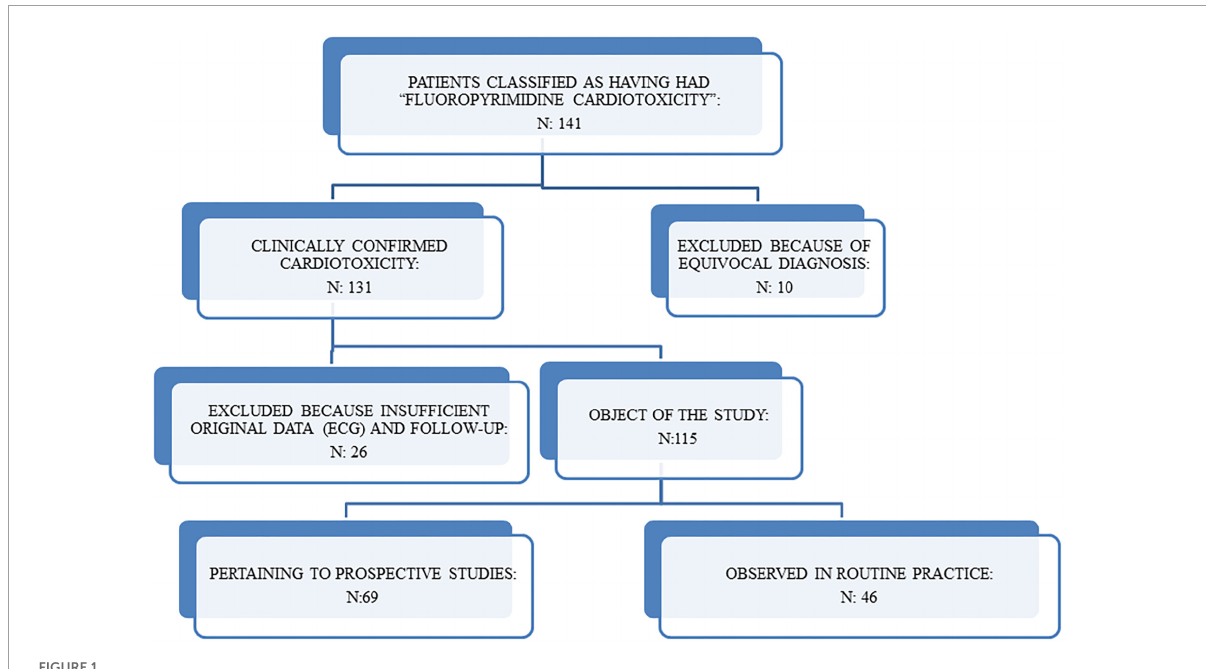
FIGURE1 Selection of population reported in the study.